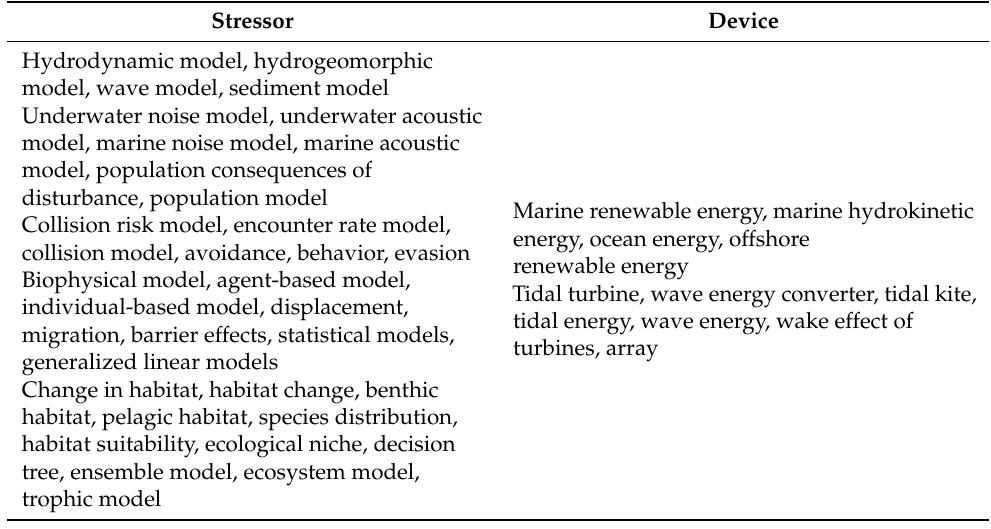
Table A1. Summary of search terms used when locating modeling studies. Search queries consisted of combinations of items in both